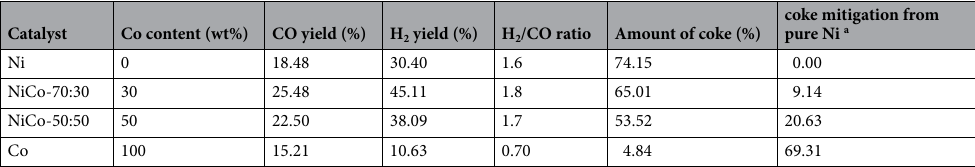
Table 1. The coke accumulation on spent Ni, NiCo of different Ni:Co ratio, and Co catalysts used in the DRM process. a Coke mitigation is calculated from the changes in coke deposition compared to pure Ni catalyst.